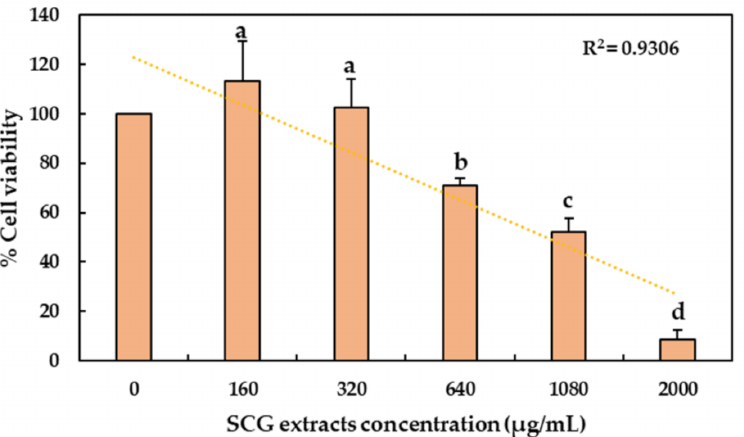
Figure 1. Effect of polyphenolic extracts from SCG on cell viability of C. viridis brain cells. Data are mean ± SD of three separate trials. Each treatment had three replicates (wells). Data are presented as the relative percentage of zero. Different letters (a, b, c, d) indicate significant differences between concentrations ( p <